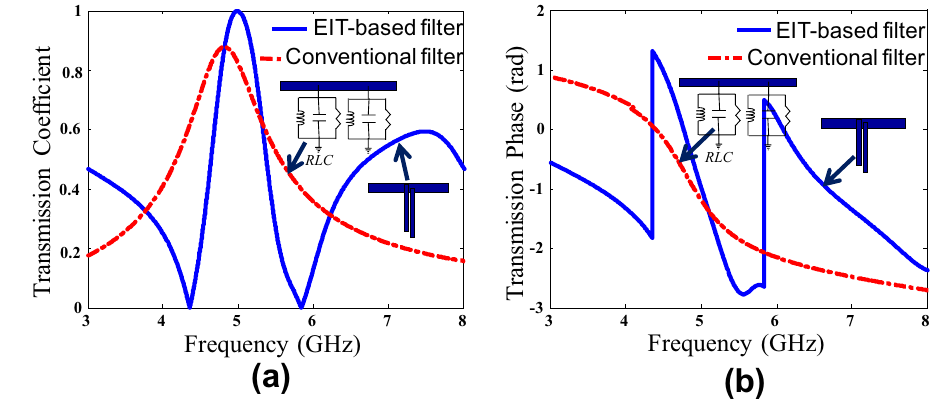
Figure 2. The transmission characteristics of a conventional bandpass filter and an EIT-based filter are analytically calculated using the FTM model ( a ) the amplitude of the transmission coefficient gradually rises for a conventional filter. For an EIT-like structure, the passband is surrounded by transmission zeroes. ( b ) the transmission phase of the EIT-like structure is characterized by sudden changes and phase slope reversals while the phase characteristics change smoothly in case of the conventional filter.